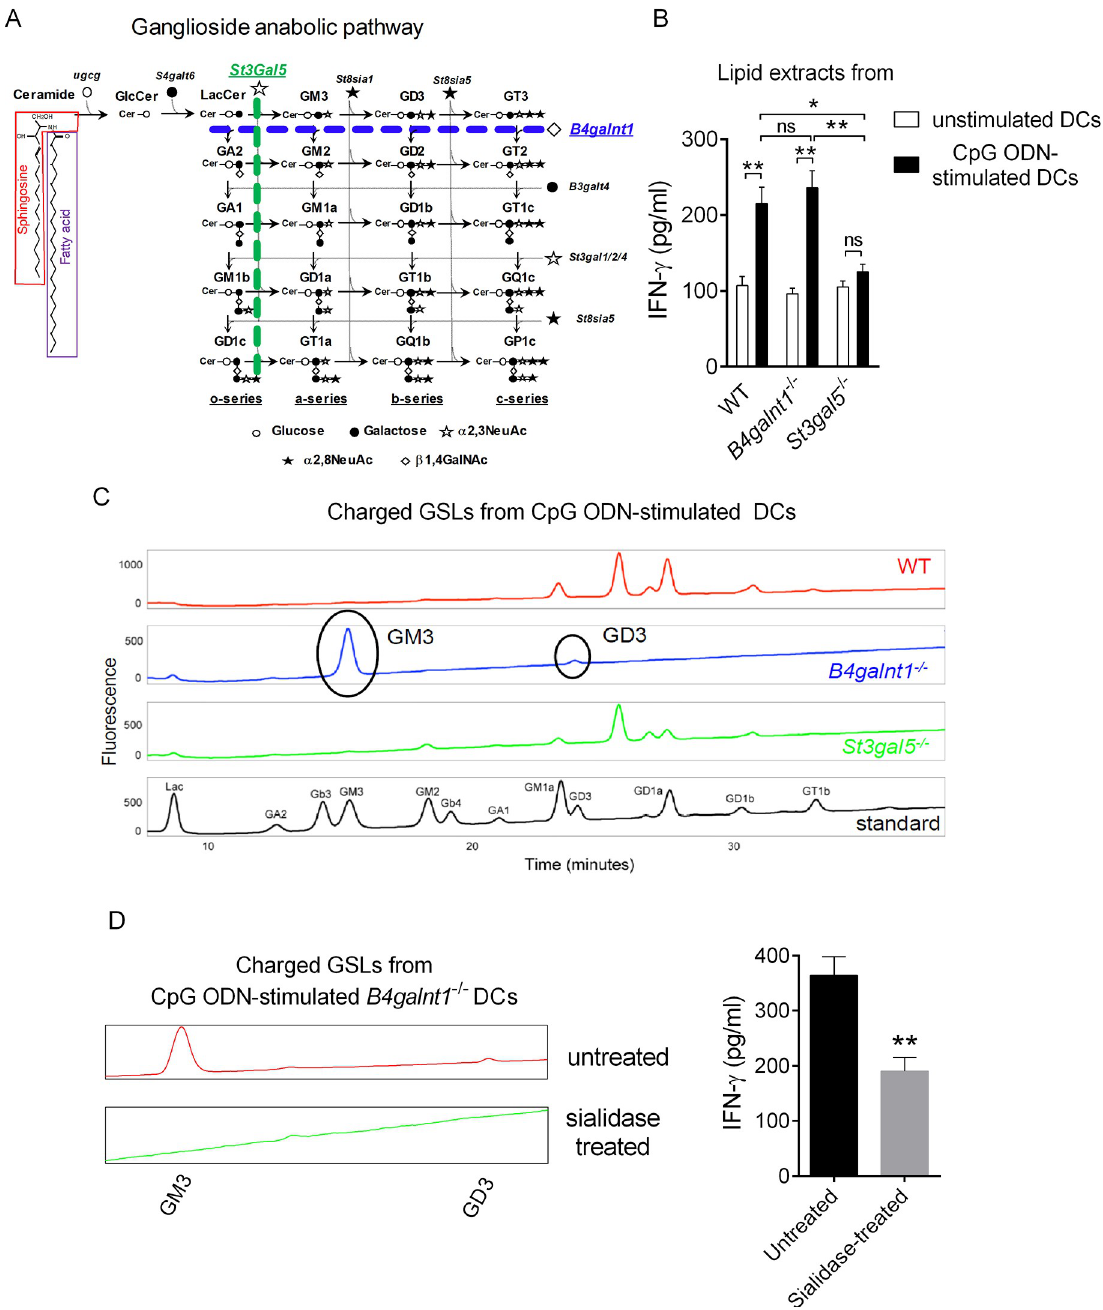
Fig 1. Endogenous ligand(s) for i NKT cells in CpG ODN-stimulated DC is/are simple sialylated gangliosides. (A) Ganglioside anabolic pathway including species and key enzymes involved is depicted. (B) Base-treated charged lipids extracted from unstimulated or CpG ODN-stimulated DCs derived from WT, B4galnt1 − / − , or St3gal5 − / − mice were exposed to DCs (1/500 in DMSO; 100,000 DCs) for 16 h and, after extensive washes, were cocultured with i NKT cell-enriched liver MNCs (500,000 cells) for 24 h. In this setting, IFN γ secretion is measured as a read-out for i NKT cell activity, although we cannot exclude that it can also be produced by other innate lymphocytes (e.g., NK cells) through bystander effect. Data represent the mean ± SEM of three independent experiments performed in duplicates. (C) Glycosphingolipids were extracted and isolated from CpG ODN-stimulated B4galnt1 − / − and St3gal5 − / − DCs, as described in the methods. Charged species were then separated from neutral species using DEAE ion-exchange chromatography prior to NP-HPLC. (D) Sialidase A- treated or untreated base-treated charged lipids extracted from CpG ODN-stimulated DCs were tested for i NKT cell antigenicity as in Fig 1B. Data represent the mean ± SEM of two independent experiments performed in triplicates. �� P < 0.01; � P < 0.05. Underlying data used in the generation of this figure can be found in S1 Data. CpG, cytosine-phosphate-guanine; DC, dendritic cell; DEAE,